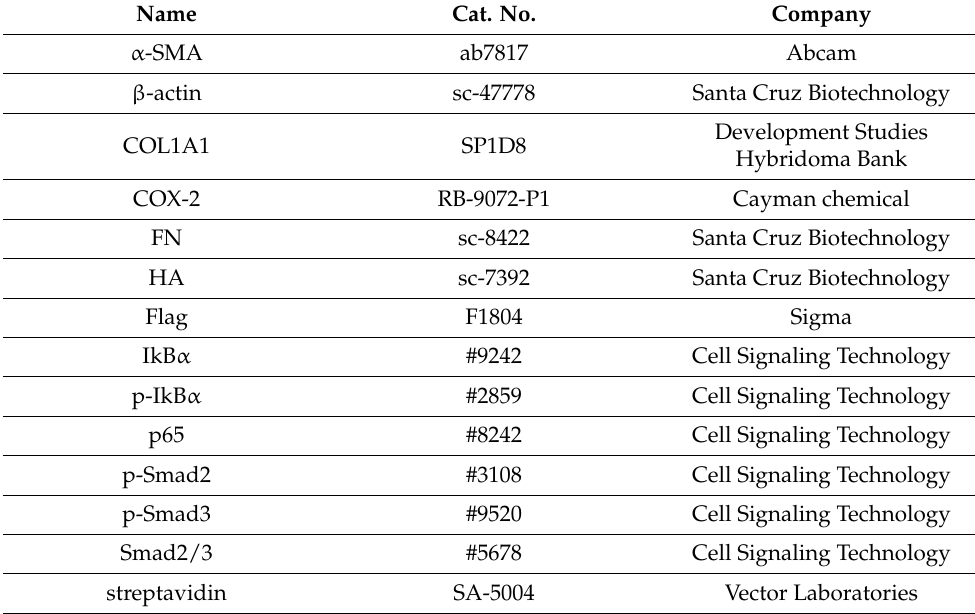
Table 1. Antibodies for